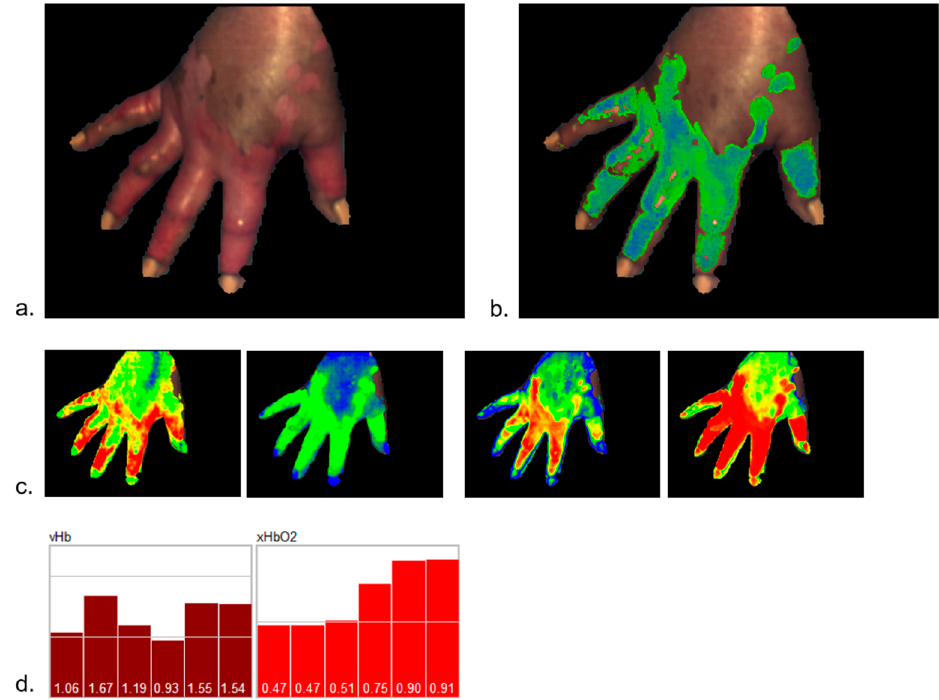
Figure 7. ( a ) Burn wound on a hand, ( c ) perfusion survey images (color scales for vHb and xHbO 2 as depicted in Figure 1) and ( b ) fuzzy classification (blue: superficial, green: partial-thickness, red: full-thickness); ( d ) perfusion profile from the burn area.